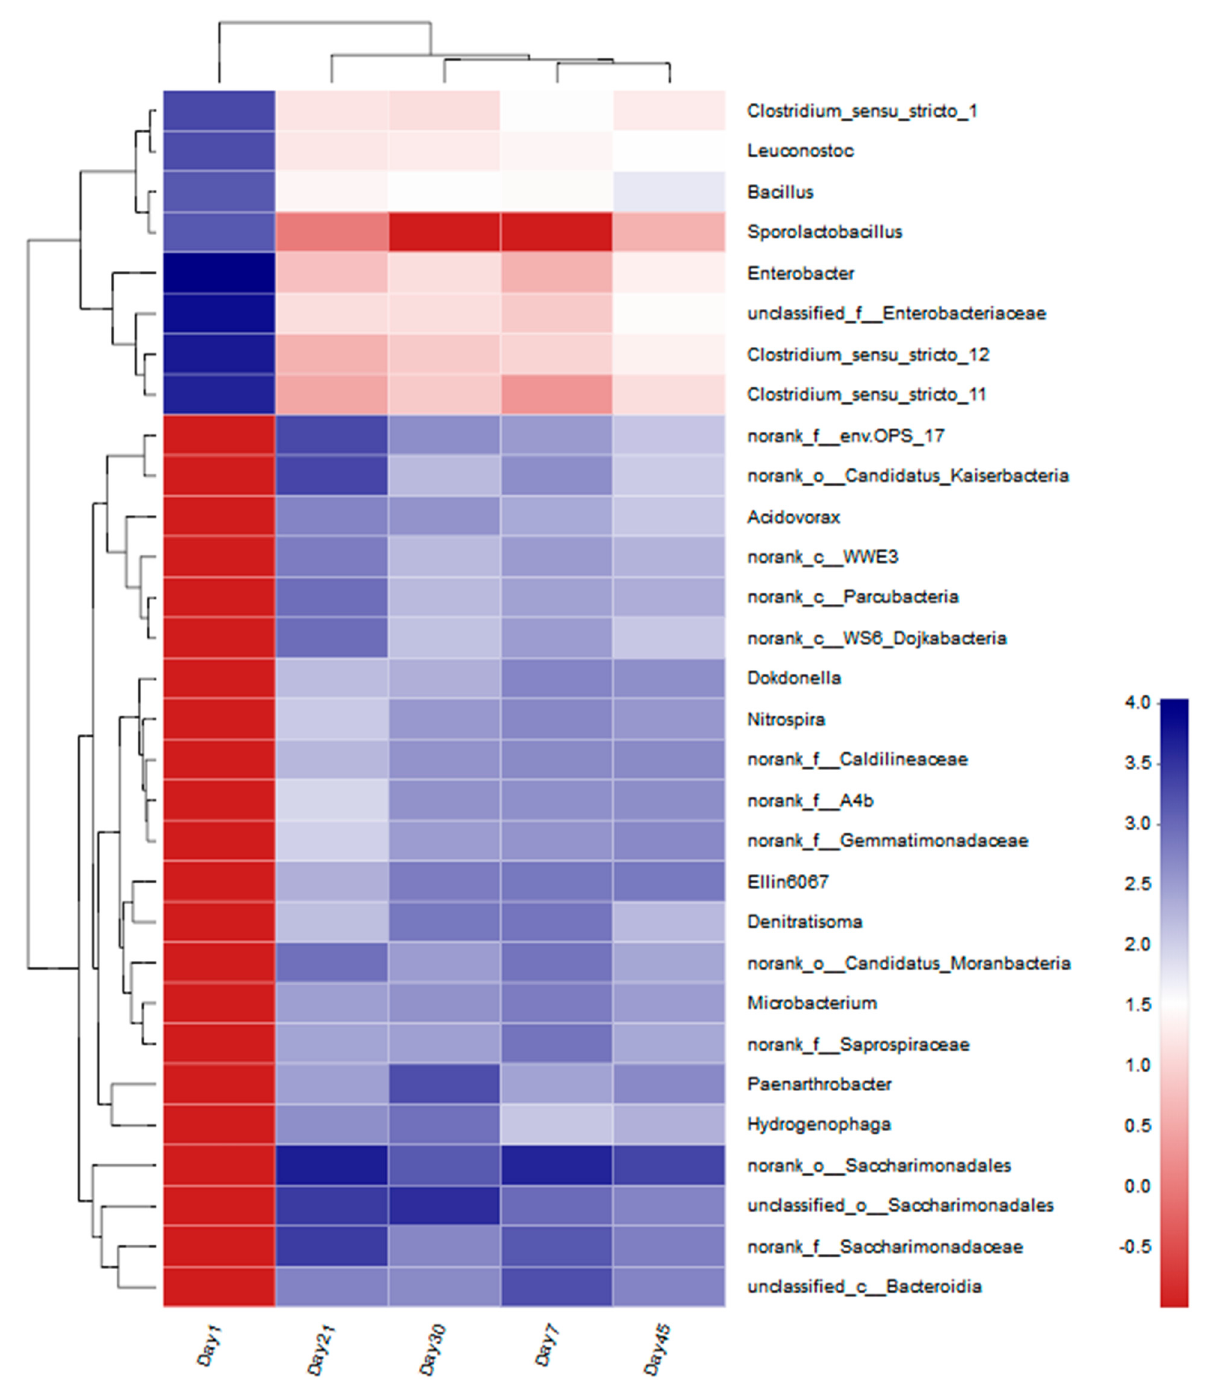
Figure 5. Heat map of the microbial community (abundance greater than 1%) at the genus level.